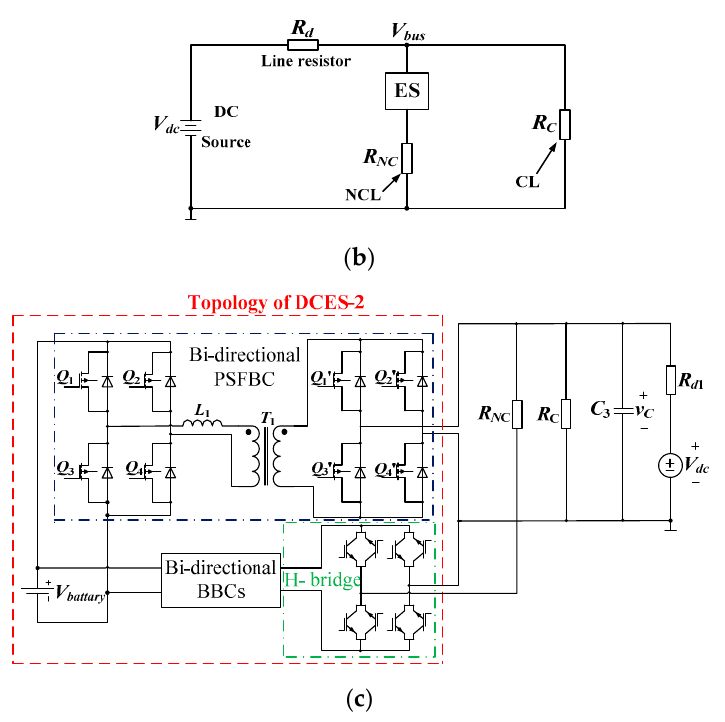
Figure 9. Typical topologies and applications of DCES in DC microgrids. ( a ) Typical application circuit of multiple DCESs [28]; ( b ) Typical application circuit of a single DCES [28]; ( c ) DCES-2 realized by DC/DC converters [29].